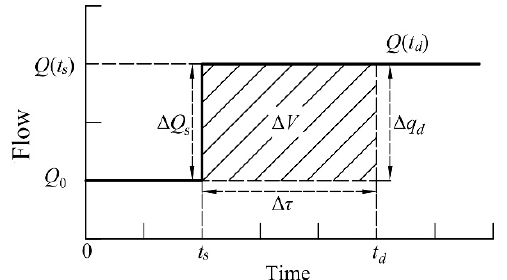
Figure 1. Schematic diagram of volume step compensation algorithm.